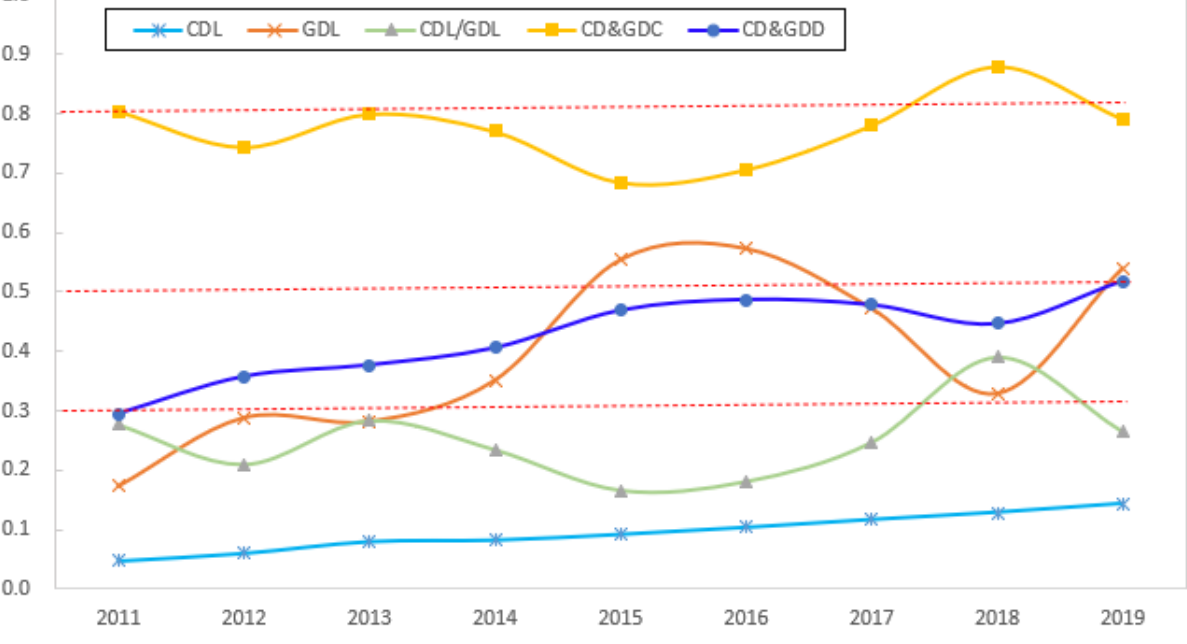
Figure 3. Time characteristics of coupling coordination relationship between urban digitalization and green development from 2011 to 2019.